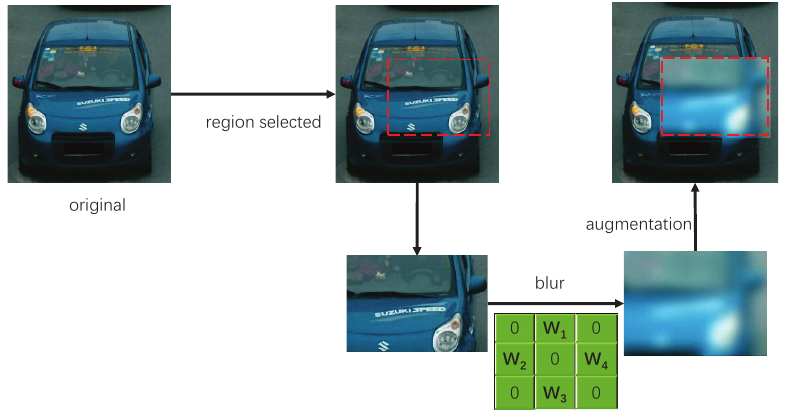
Figure 8. Workflow of local blur